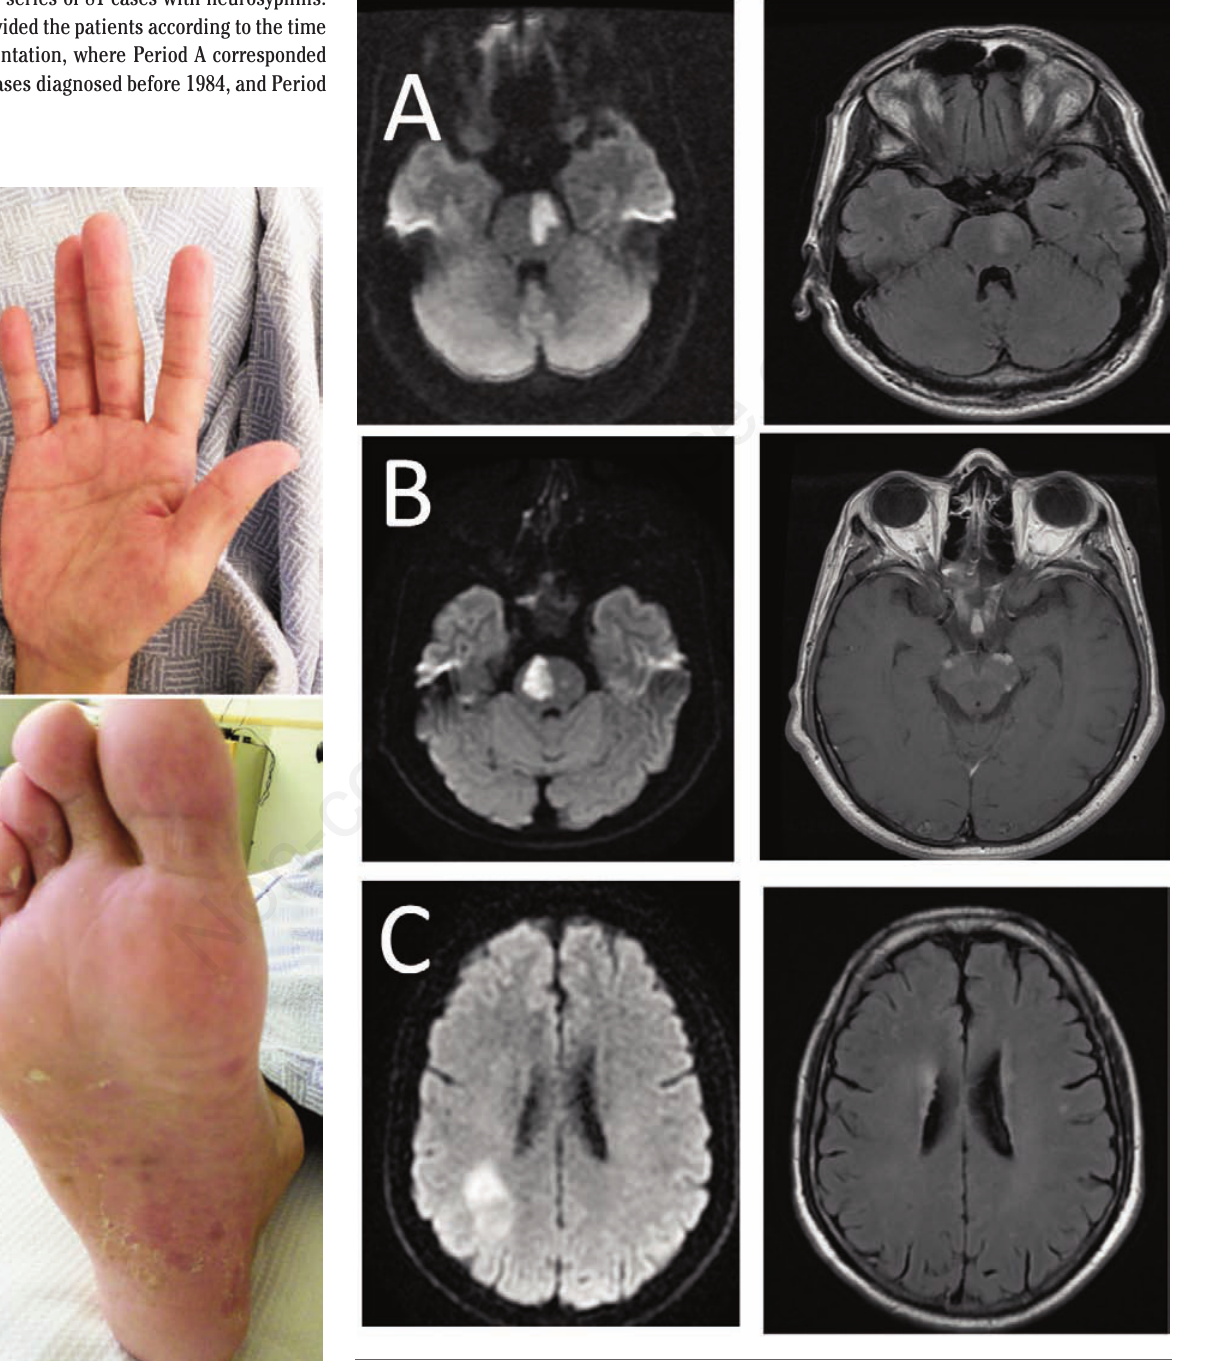
Figure 2. Axial magnetic resonance images. A) Case 4: left hiperintense signal of the pons (DWI/FLAIR); B) Case 6: right hiperintense signal of the pons (DWI) and perimesen- Figure 1. Secondary syphilis at neurologi- cephalic enhacement (T1G); C) Case 15: right hyperintense signal on the parietal lobe cal onset.